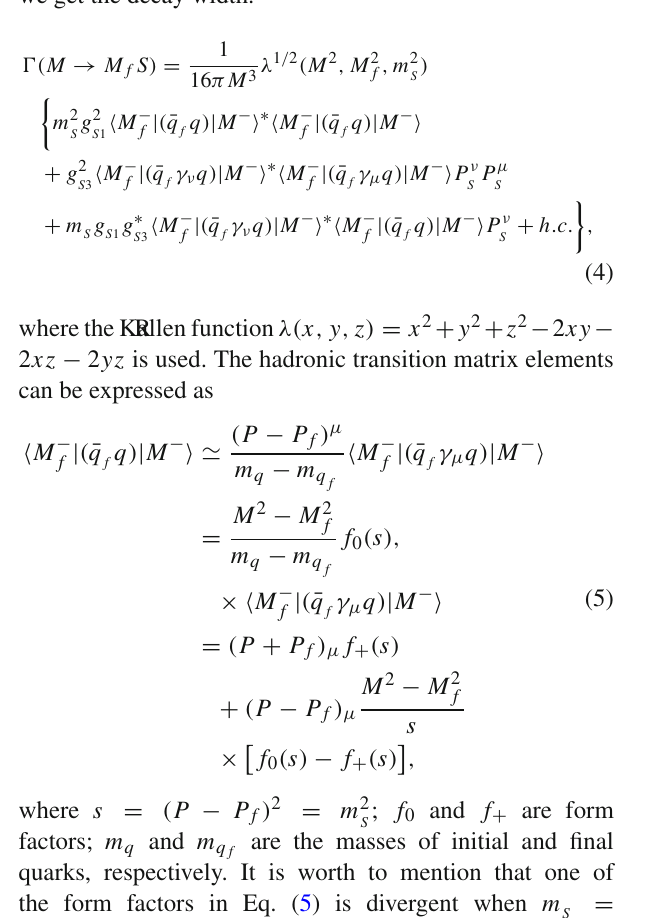
Fig. 1 Feynman diagram of decay channels involving invisible parti- cles, (cid:7) (cid:6) (cid:8) = d PS 3 | T 1 ( 3 ) | 2 , which are Here we have defined 1 ( 3 ) independent of the coefficients. When the final meson is a pseudoscalar, by finishing the two-body phase space integral, we get the decay